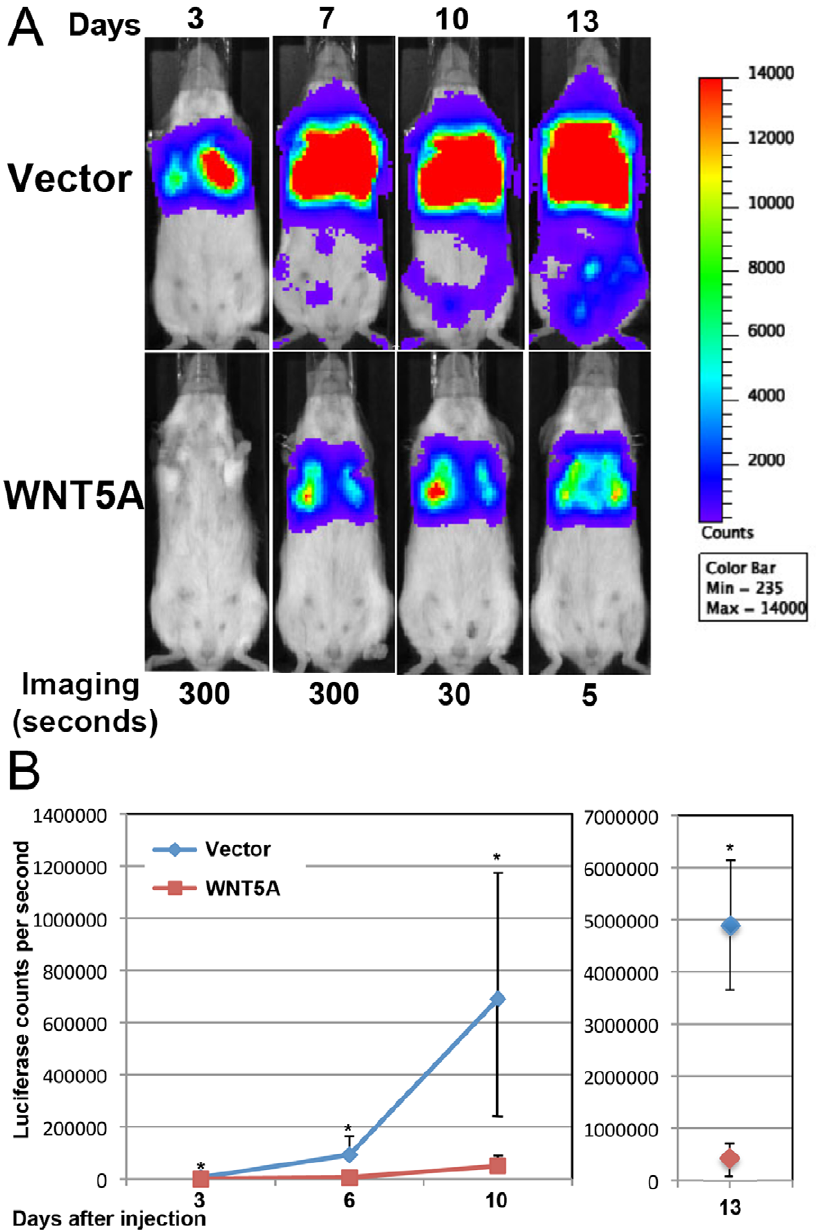
Figure 2. WNT5A inhibits metastasis to the lung. The tail vein assay was used to compare metastasis to the lung of vector only transduced 4T1- luc (Vector) and WNT5A expressing 4T1-luc (WNT5A) cells. (A) Luciferase imaging over several days after injection is shown. Red represents the highest intensity of luciferase signal. The imaging time in seconds is shown at the bottom. (B) The average and standard deviation from 6 mice in each group of luciferase counts per second is shown over time. Luciferase counts were significantly reduced in 4T1-Luc-WNT5A cells starting at 3 days after injection (*T-test p-value , 0.05). Note Day 13 results are shown on a different scale.